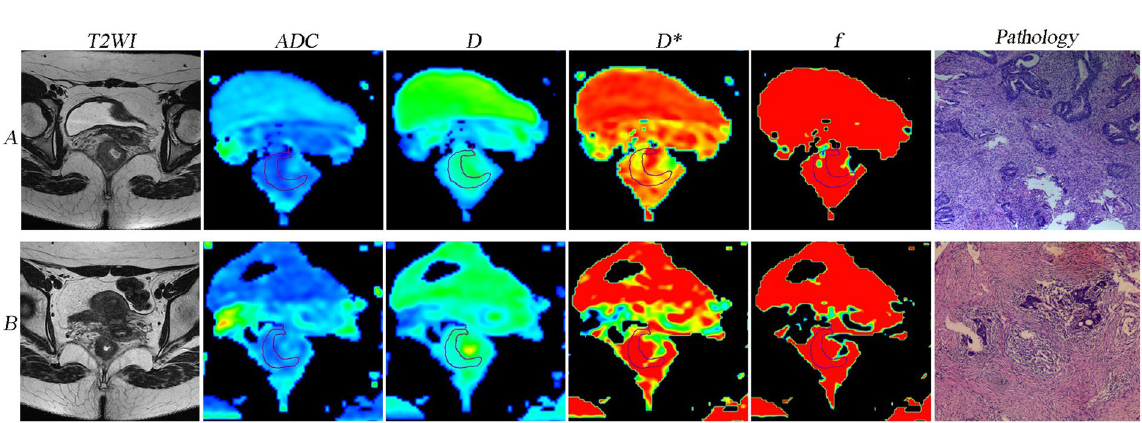
Figure 2. A LARC patient from the non-pCR and PR groups (TRG 2). Images in row A and B are T2WI, IVIM- DWI parametric and pathological maps before and after nCRT, respectively. The ADC, D, D * and f values before nCRT were 1.1 × 10 − 3 mm 2 /s, 0.925 × 10 − 3 mm 2 /s, 40.3 × 10 − 3 mm 2 /s and 0.165, respectively. The ADC, D, D * , and f values after nCRT were 1.69 × 10 − 3 mm 2 /s, 1.61 × 10 − 3 mm 2 /s, 37.1 × 10 − 3 mm 2 /s and 0.118, respectively. The pathology map (haematoxylin-eosin staining, original magnification x40) after nCRT indicates an increased number of residual cancer cells with predominating fibrosis (TRG 2). LARC, locally advanced rectal cancer; non-pCR, non-pathological complete response; PR, poor response; TRG, tumour regression grade; T2WI, T2- weighted imaging; IVIM-DWI, intravoxel incoherent motion diffusion-weighted imaging; nCRT, neoadjuvant chemoradiotherapy; ADC, apparent diffusion coefficient; D, pure diffusion coefficient; D * , pseudo-diffusion coefficient; f , perfusion